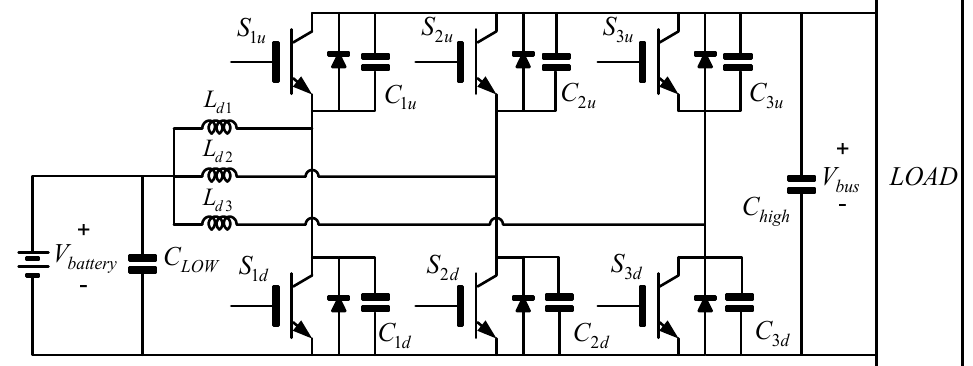
Figure 10. ZVS based three phases interleaved synchronous mode non–isolated bidirectional DC–DC converter [22].